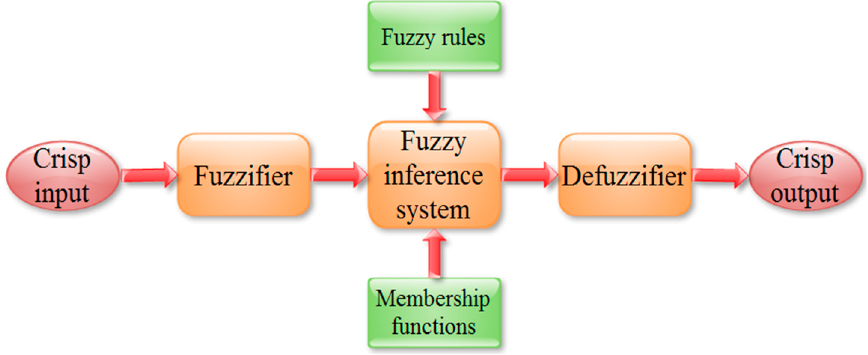
Figure 1. Schematic of the fuzzy inference system.